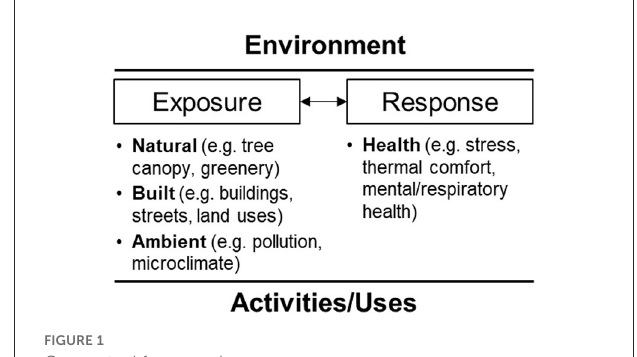
FIGURE1 Conceptual